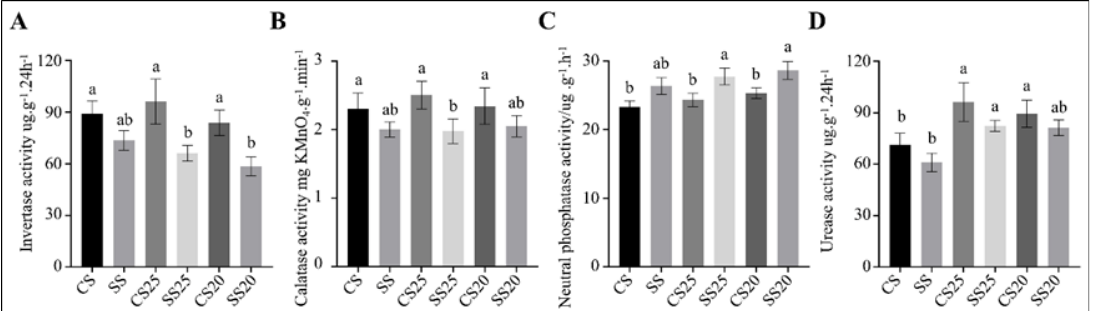
Figure 7. Soil enzyme activities of the peanut spermosphere soils and the bulk soils. Soil ( A ) invertase, ( B ) calatase, ( C ) neutral phosphatase, and ( D ) urease activities of the peanut spermosphere soils and the bulk soils. Error bars indicate the SEM ( n = 3). One-way ANOVA Duncan’s test. Different lowercase letters represent different significance.